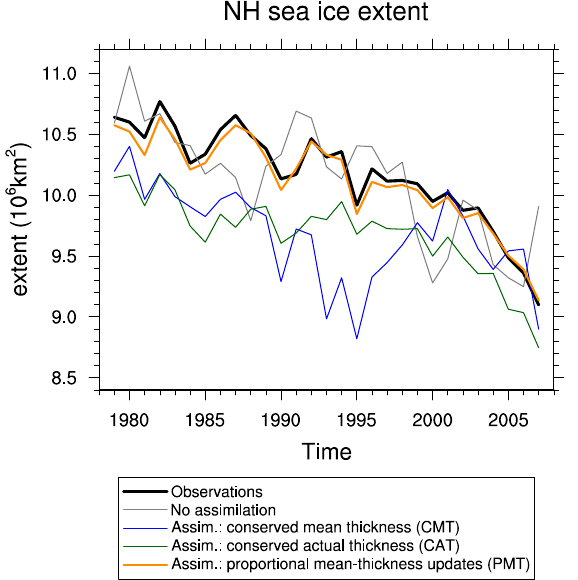
Fig. 3. Annual mean ice extent in the Northern Hemisphere from observations (black), a model run with no assimilation (grey), and from the different assimilation methods (colours). The correspond- ing time-averaged global extent errors δ SIE are given in Table 1. Fig. 4. The average point-wise error in sea-ice concentration for the Arctic Ocean for each month of the year. All errors are obtained from the differences to the observed concentration